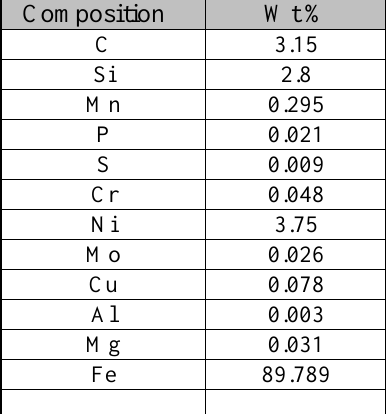
Table 4: Chemical components of cast iron (grey cast